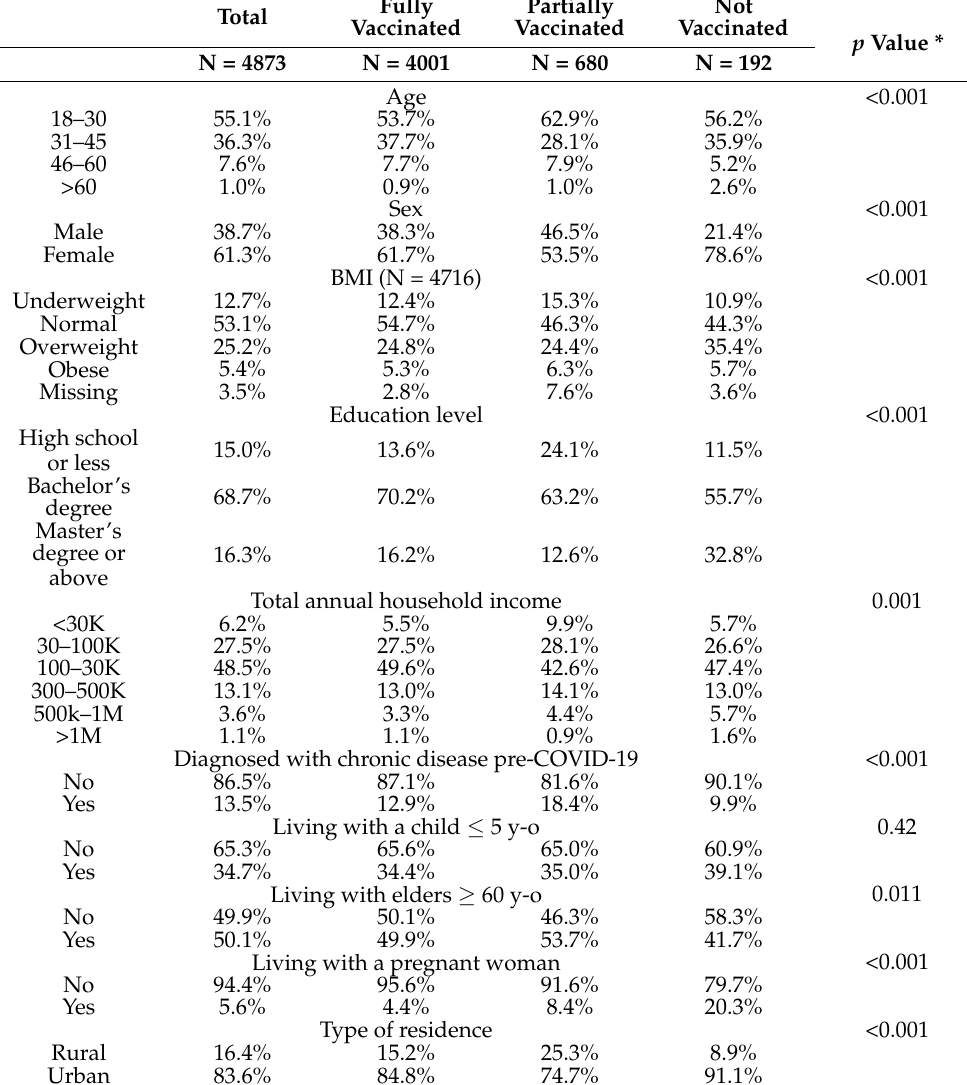
Table 1. Study participant characteristics by vaccination